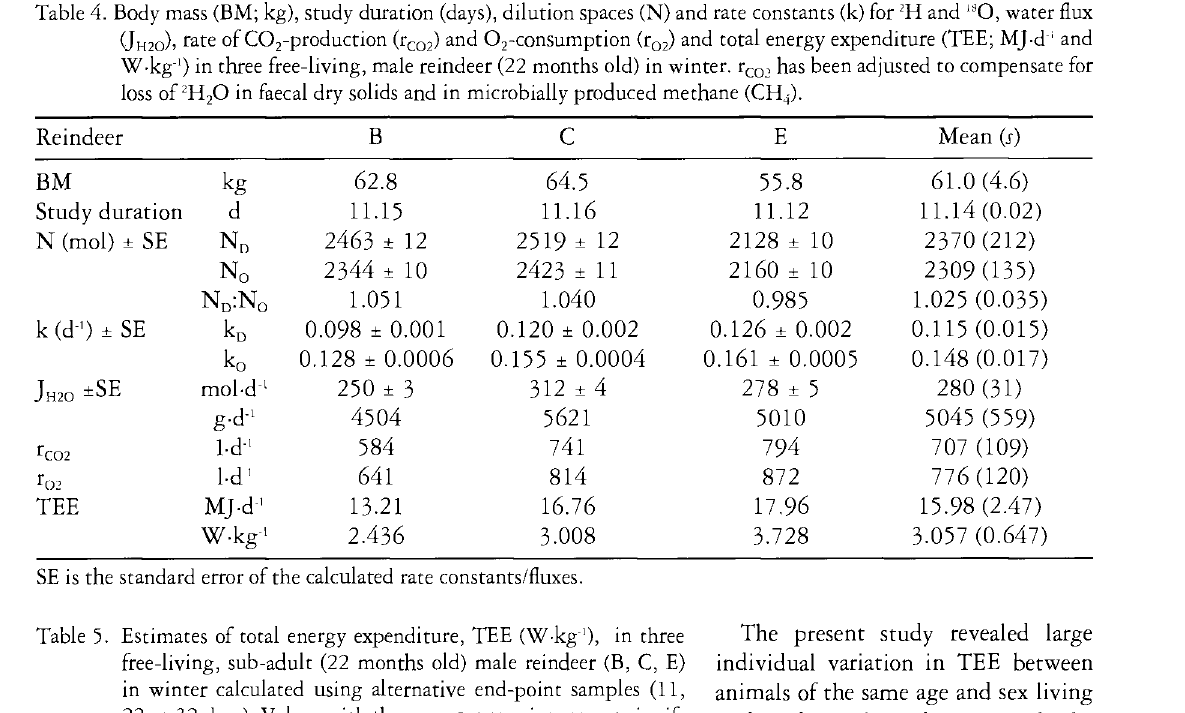
Table 5. Estimates of total energy expenditure, TEE (W-kg" 1 ), in three free-living, sub-adult (22 months old) male reindeer (B, C, E) in winter calculated using alternative end-point samples (11, 22 or 32 days). Values with the same superscript are not signif icantly different (Mann-Whitney {/-test, P > 0.05).